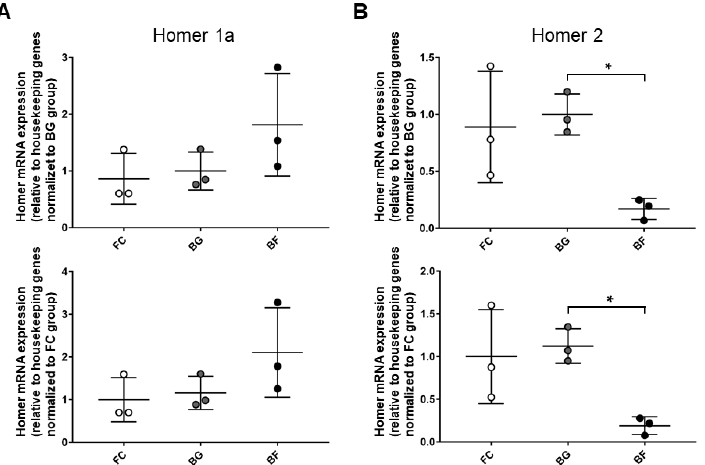
Figure 1. Homer1a and Homer2 genes are differentially regulated in SOL muscle of Bion-M1 flown mice. Results qPCR data analysis. ( A ) An increased, albeit not statistically significant, value of Homer1a mRNA expression was observed in SOL muscle of BF vs. BG (61.5%; p ≤ 0.789) and BF vs. FC (110%; p ≤ 0.177). ( B ) A significant decrease in Homer2 mRNA expression was observed in SOL muscle of BF vs. BG ( − 84%; p ≤ 0.021) and BF vs. FC ( − 81%; p ≤ 0.0664). mRNA levels were normalized to housekeeping genes by the delta Ct method and then normalized to CON (BG up- per panel and FC lower panel), which was arbitrarily set to 1. Data are expressed as means ± SE. For each experimental group, n = 3 male C57BL/N6 mice (19–20 weeks old). Statistical differences between groups were determined by an unpaired t -test. *= indicates significant difference vs. CON (ANOVA p < 0.001).